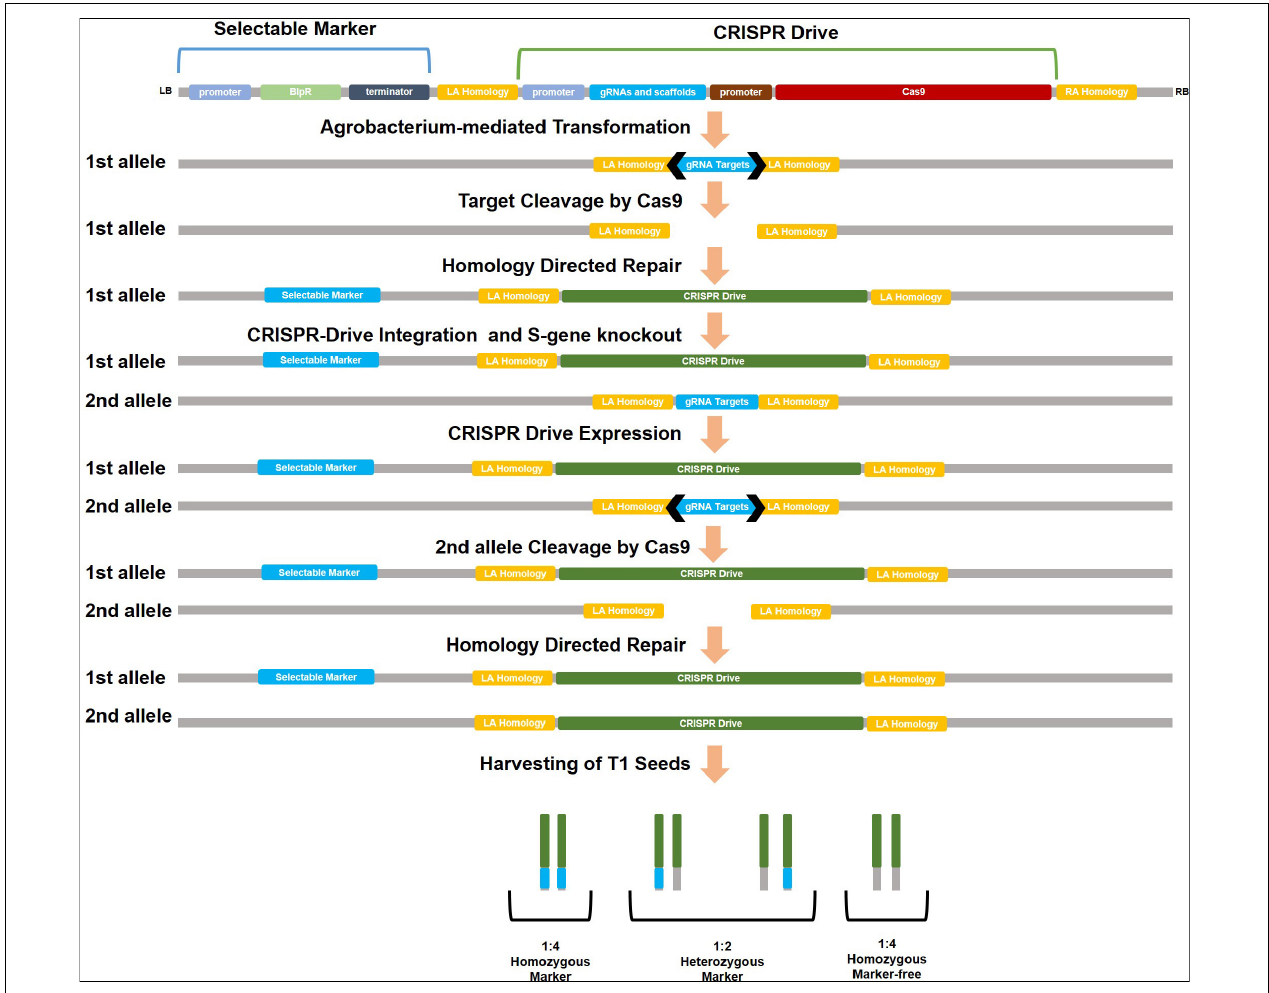
FIGURE 1 | Development of S -mutant plants with CRISPR drive and schematization of drive cassette. Using disruption of meiotic control 1 (DMC1) and egg cell-specific (EC) promoters for Cas9 in drive cassette can increase HDR activity in the plant. Selectable marker (antibiotic/herbicide resistance, fluorescent, or different reporters) is cloned outside of homology arms (LA-RA homology) in CRISPR drive cassette. Thus after the cleavage at the second allele, selectable marker coding fragments could not be integrated into the second allele during